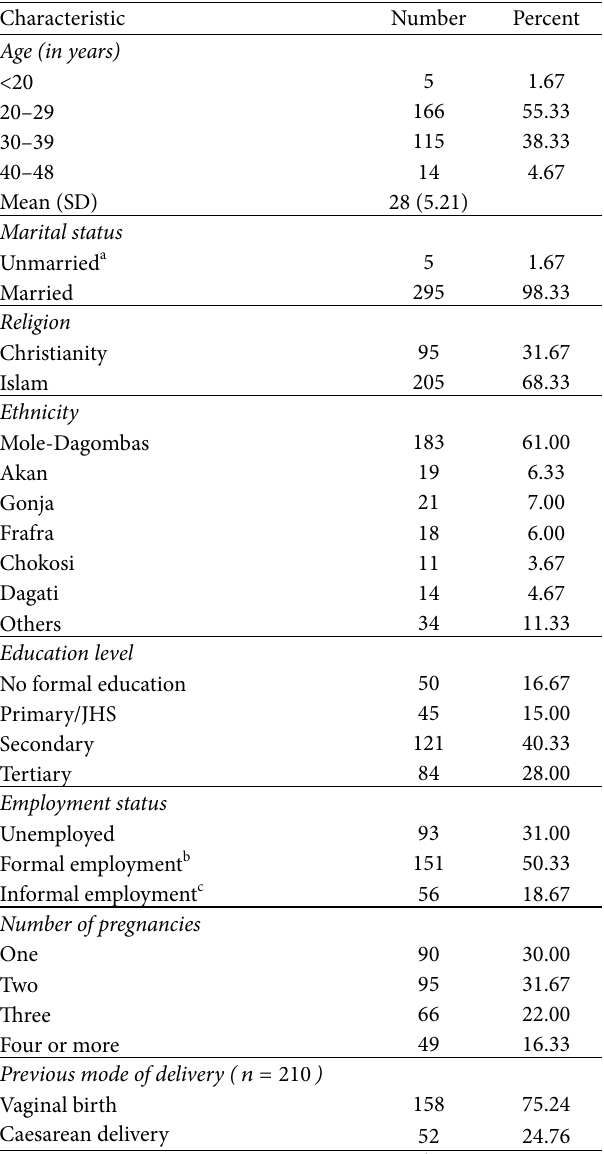
Table 1: Background characteristics of